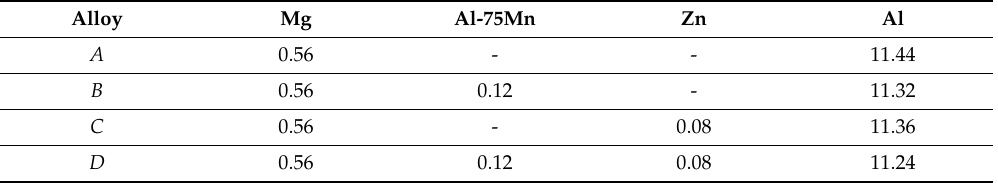
Table 1. Preparation of materials for each experimental alloy (kg).